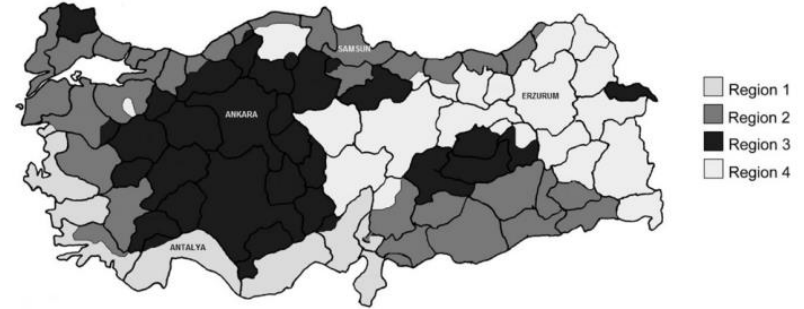
Figure 3. Climate zones of selected cities in the study (TS, 825).